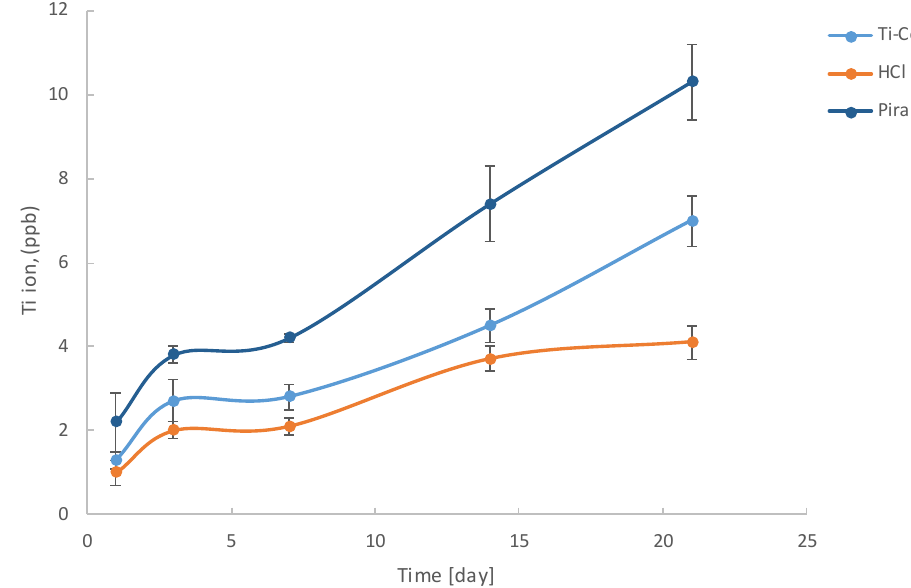
Table 5. Ti ion release (ppb) at different incubation times in Hank’s solution.